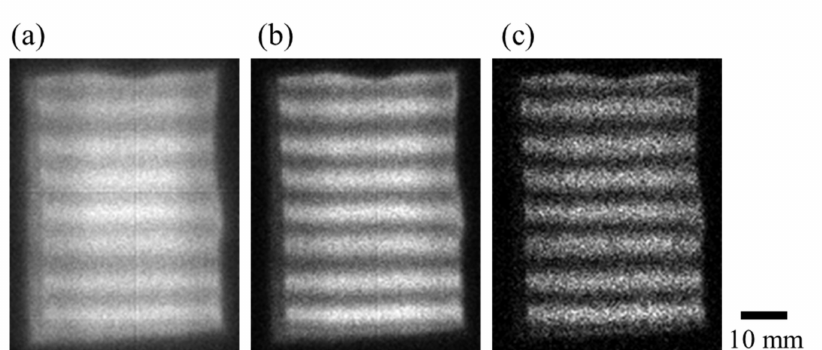
Figure 4. Moir é patterns recorded by neutron Talbot–Lau interferometer with RANS. ( a ) Moir é pattern by all neutrons without TOF treatment, ( b ) moir é pattern by neutrons of wavelengths from 1.2 to 3.6 Å, and ( c ) moir é pattern by neutrons of wavelengths from 2.2 to 2.5 Å. The visibilities of the moir é patterns ( a – c ) are 0.14, 0.37, and 0.59, respectively. The gray scales of ( a – c ) are [0, 470], [0, 188], and [0, 25] in count per pixel, respectively.